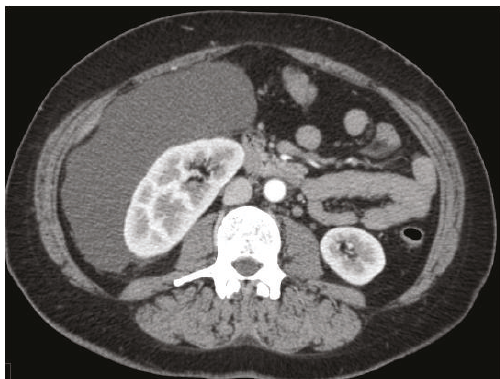
Figure 1: Computed tomography showing a 14 cm, well-circum- scribed, enhanced round tumor with solid and cystic components arising in the right adrenal gland.